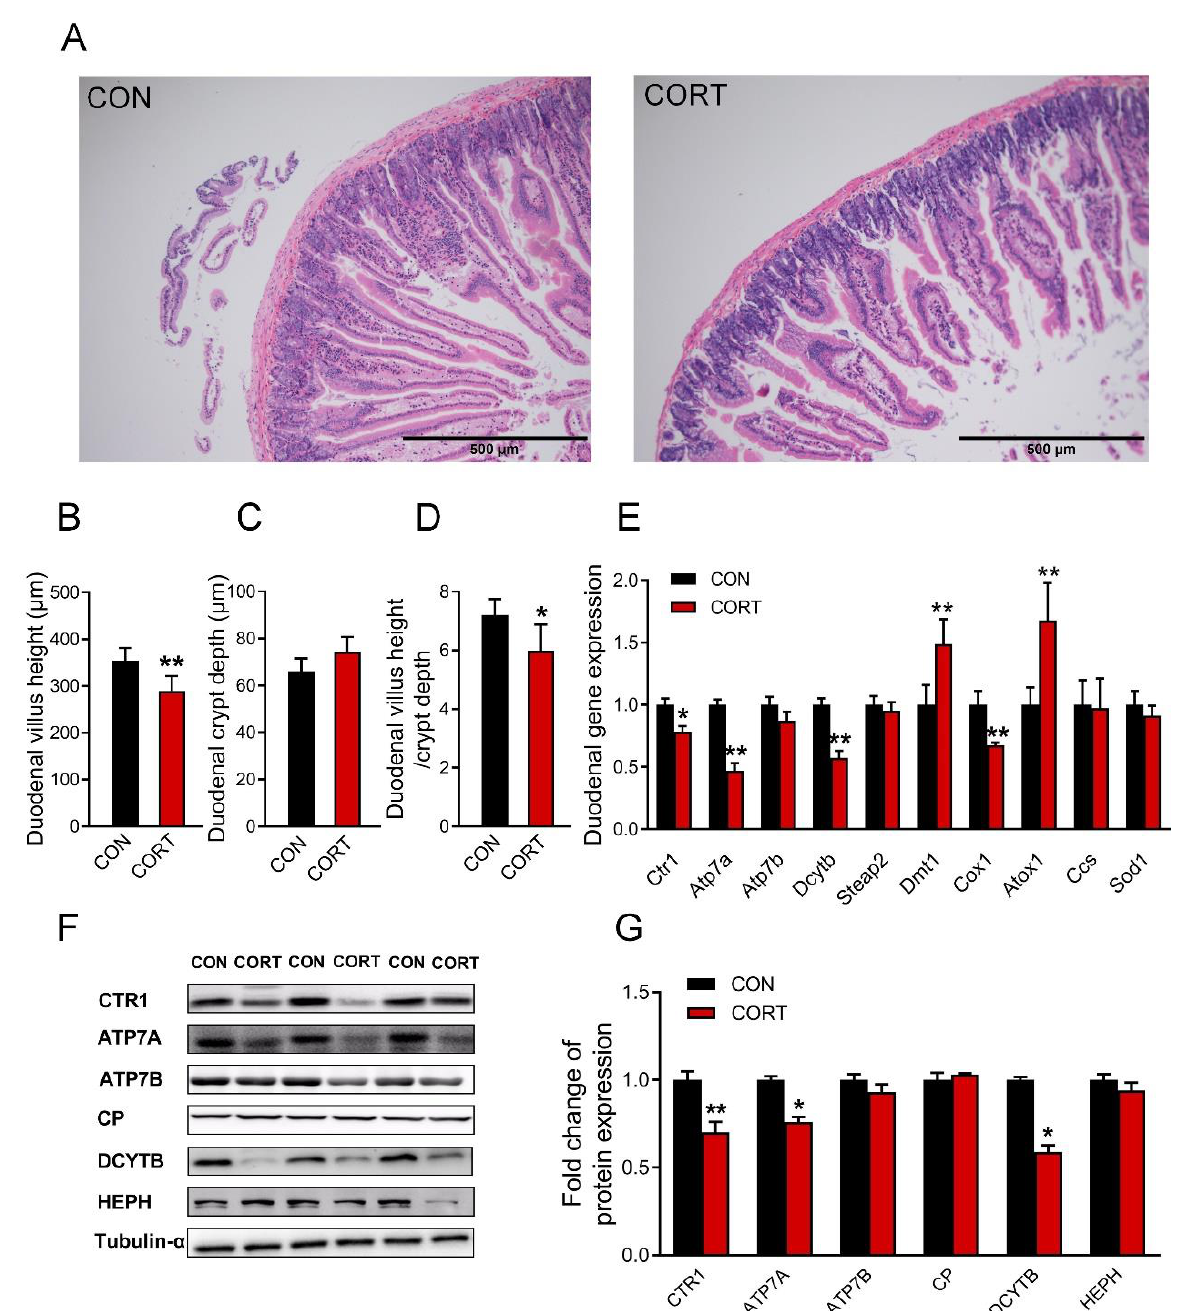
Figure 2. Corticosterone exposure damages the structure of the duodenum and reduces the content of copper absorption and transport-related proteins. (A) H&E staining of the duodenum (n = 3) . (B-D) Duodenal villi height, crypt depth, and the ratio of the two groups (n = 12). (E) mRNA expression of Ctr1 , Atp7a , Atp7b , Dcytb , Steap2 , Dmt1 , Cox1 , Atox1 , Ccs, and Sod1 were evaluated by qPCR (n = 6). (F, G) Western blot analyses of CTR1, ATP7A, ATP7B, CP, DCYTB, HEPH and Tubulin- α proteins (n = 6). CON = control group; CORT = corticosterone exposure group. Values are means ± SEM, * P < 0.05, ** P <